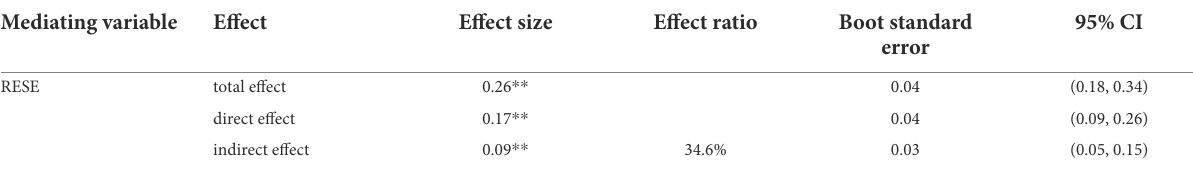
TABLE 2 The mediating role of